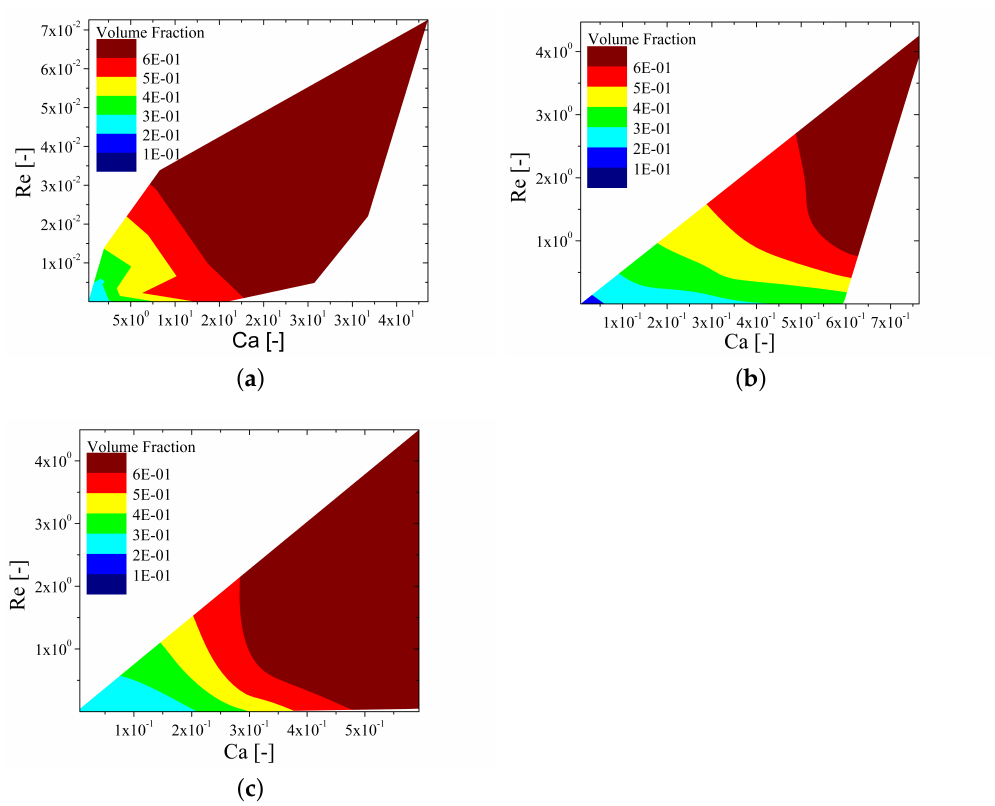
Figure 11. Contour plots of the volume fraction as a function of the capillary number and the Reynolds number for the three different inks considered: ( a ) HexaS, ( b ) Hexa1, and ( c ) Newtonian.